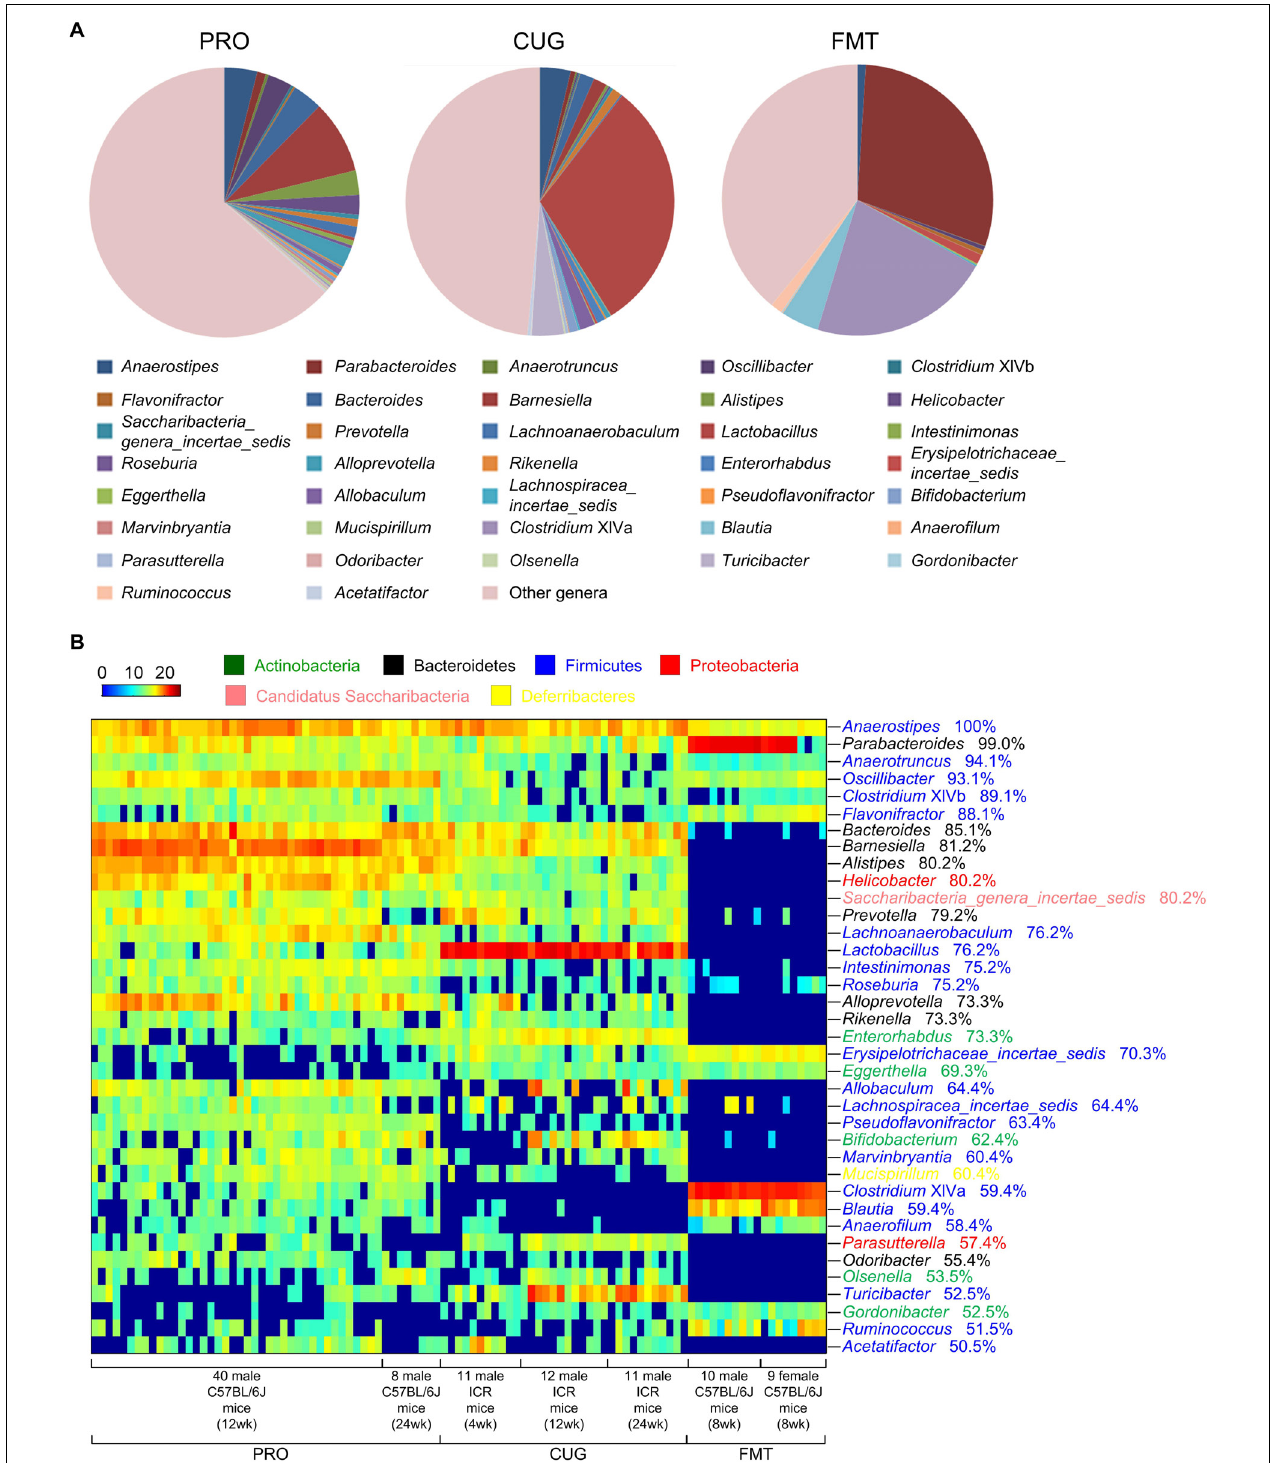
FIGURE 1 | Thirty-seven core genera were identified in more than 50% of the feces of 101 healthy mice. (A) The proportion of each genus in the total sequences of each dataset. (B) The heatmap of the relative abundance (log 2 transformed) of the 37 core genera in 101 healthy mice. Rows corresponded to the 37 core genera in the feces of 101 healthy mice. These genera were presented in order of prevalence (100–50.5%). The taxonomies of the genera were shown on the right, followed by the prevalence, and colored according to phylum. Columns represented 101 healthy mice samples in the three datasets. The 101 mice were grouped based on their sex, age, and